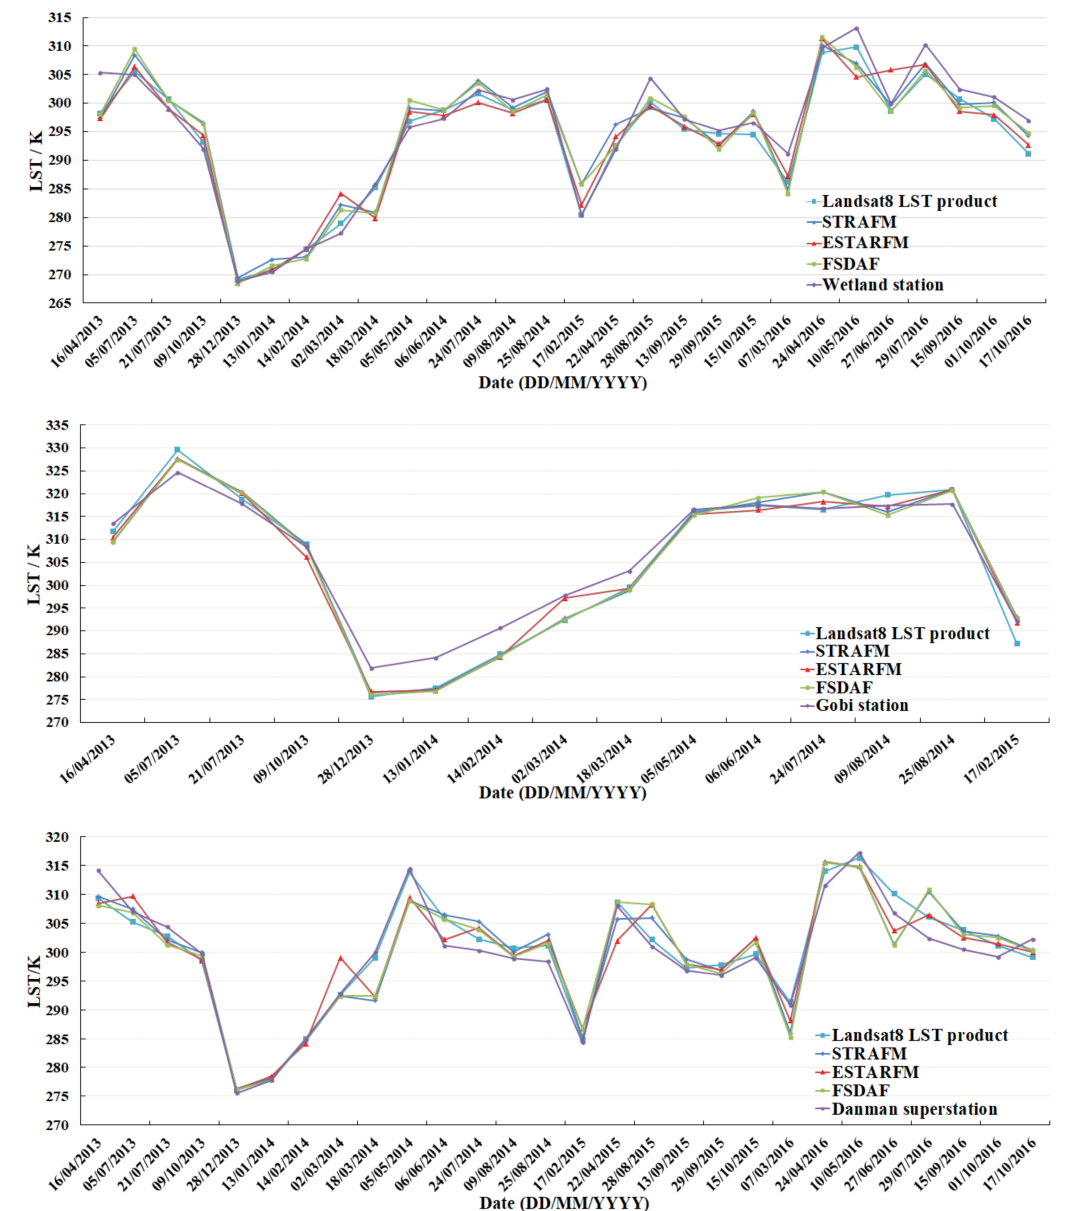
Figure 5. Time series comparison of fused and measured